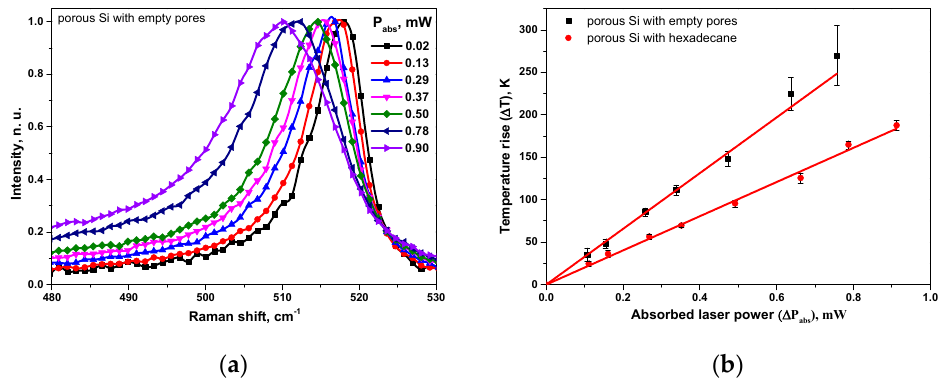
Figure 2. ( a ) Raman peak position of a porous Si layer of 80% porosity with empty pores at various absorbed laser power; ( b ) temperature rise induced by absorbed laser power for porous Si layers with empty pores and pores filled with hexadecane (4 repetitions were performed for each experimental point).